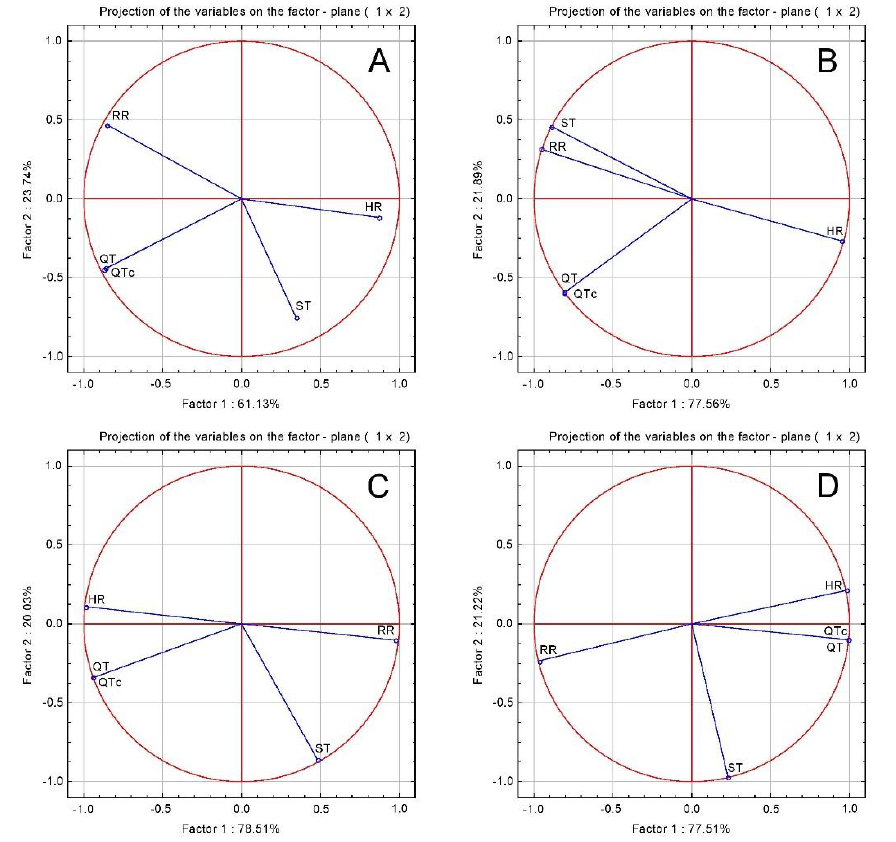
Figure 1. ECG parameters principal component analysis (PCA) results: ( A ) ISO group; ( B )